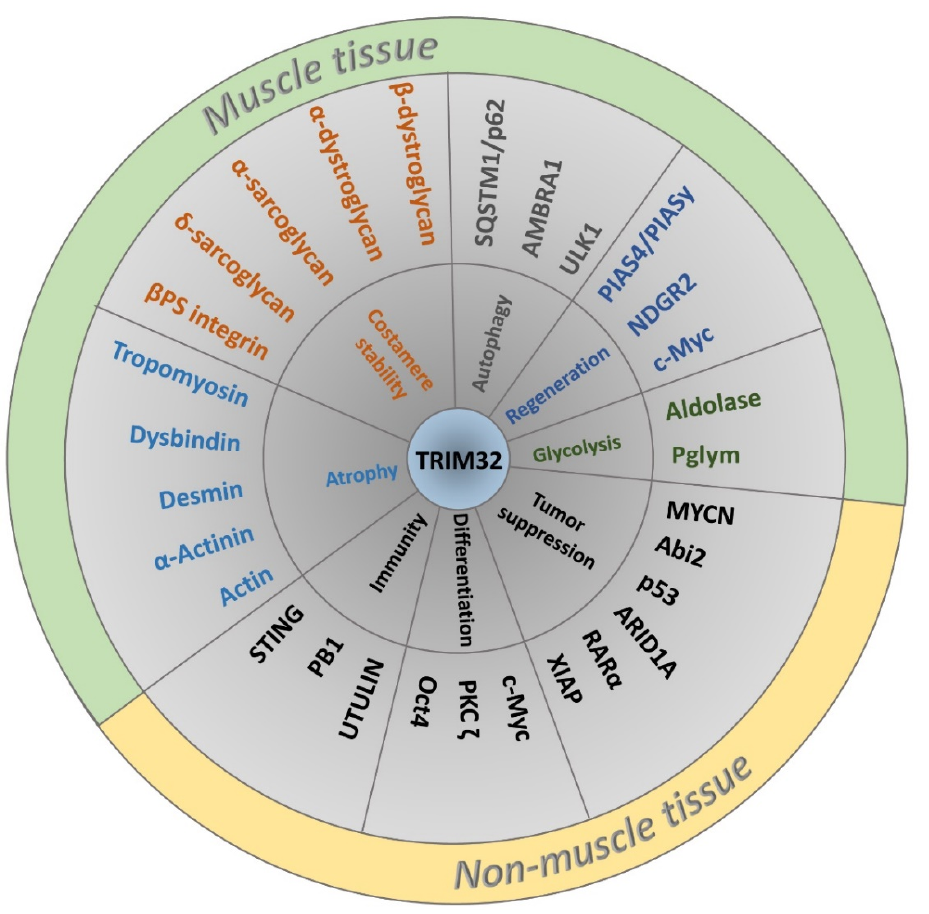
Figure 4. Classification of TRIM32 interacting proteins according to biological function and tissue specificity. The generalized role of TRIM32 in various biological processes is depicted in the inner circle followed by TRIM32 binding partners and/or substrates of E3 activity in the middle ring. Proteins with muscle-related functions are colored according to biological role.